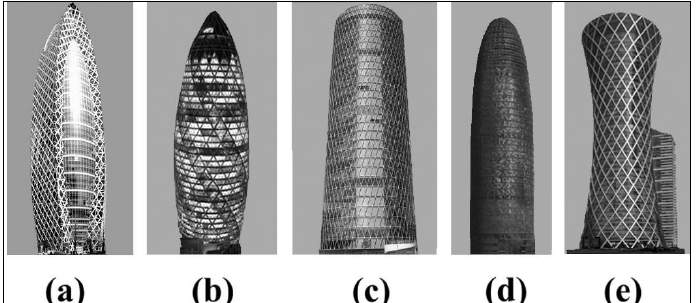
Figure 2. Rotor type of high-rise buildings: ( a ) Mode Gakuen Cocoon Tower (Tokyo, tube system with concrete columns), ( b ) Swiss Re (London, diagrid frame tube system), ( c ) Westhafen Tower (Frankfurt,